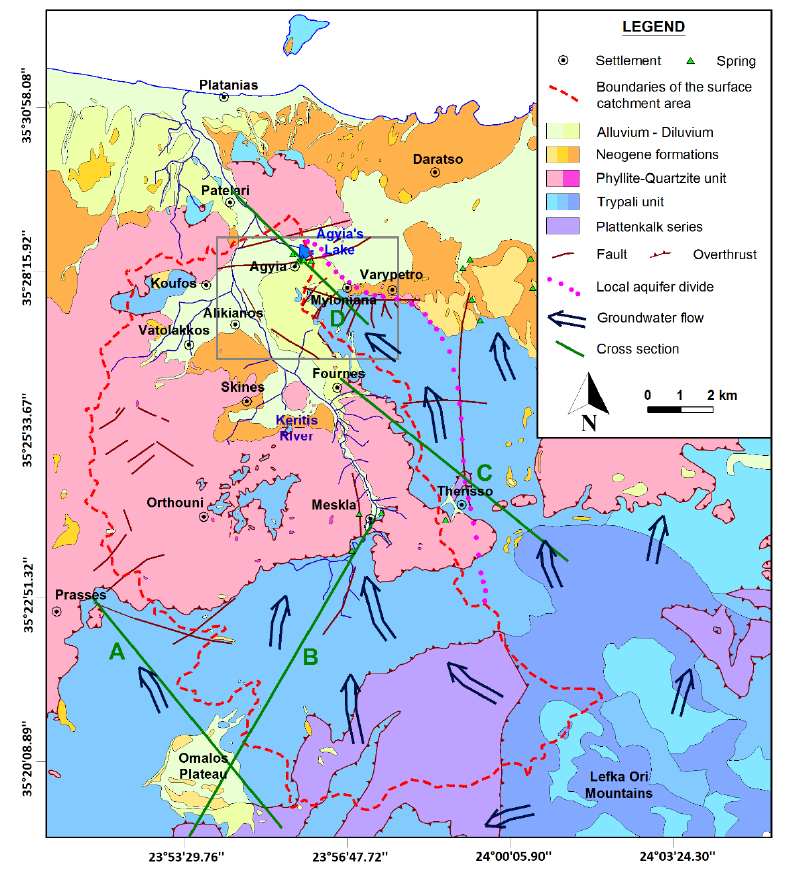
Figure 2. Geological map of the study area. The rectangle shows the area of the detailed flow